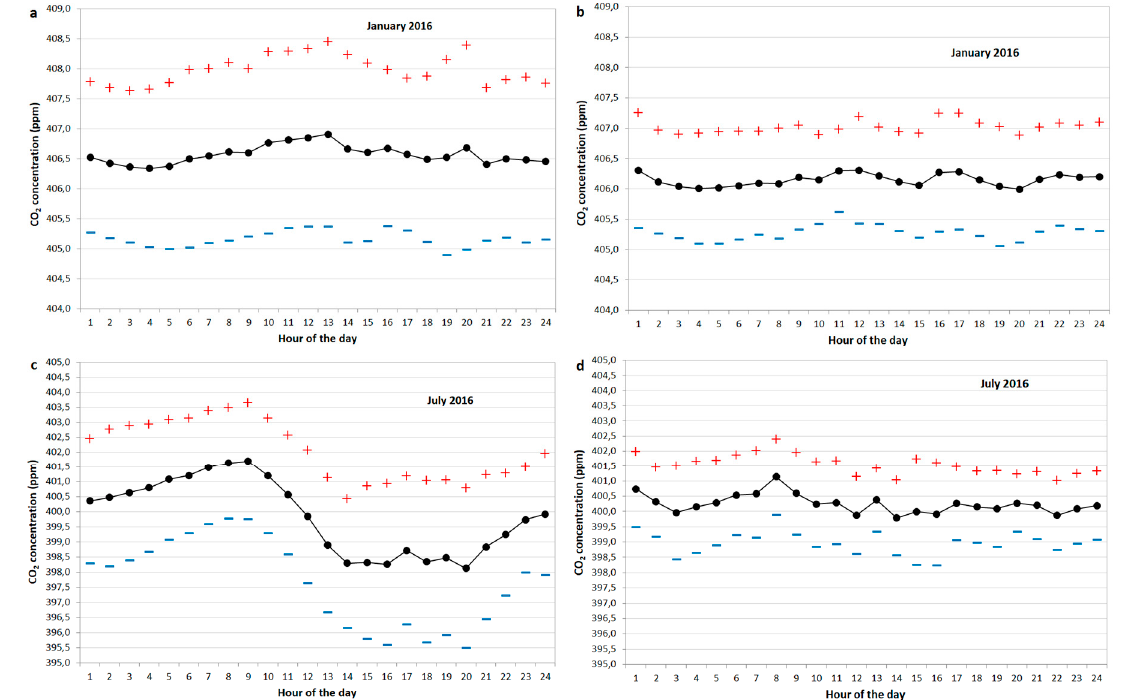
Figure 6. Mean CO 2 diurnal cycle recorded at PRS in January 2016 using non filtered data (black points), plus the standard deviation (red plus), minus the standard deviation (blue dashes) ( a ); and using filtered background data ( b ); as ( a ) but related to July 2016 ( c ); as ( b ) but related to July 2016 ( d ).